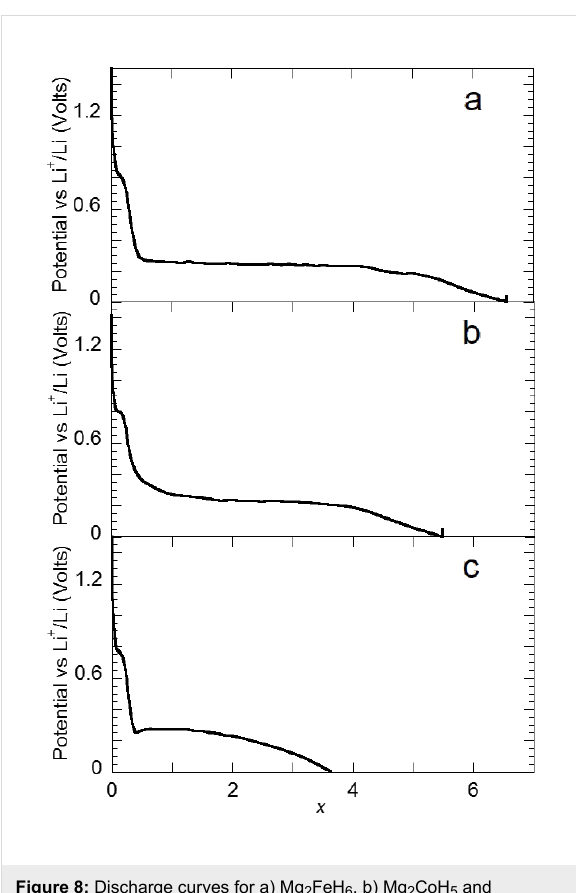
Figure 8: Discharge curves for a) Mg 2 FeH 6 , b) Mg 2 CoH 5 and c) Mg 2 NiH 4 electrodes prepared by reactive grinding as a function of Li ( x ) mole fraction, recorded at a current rate of one equivalent of Li in 10 h. Adapted from [13] (copyright 2013 Elsevier) and [19].